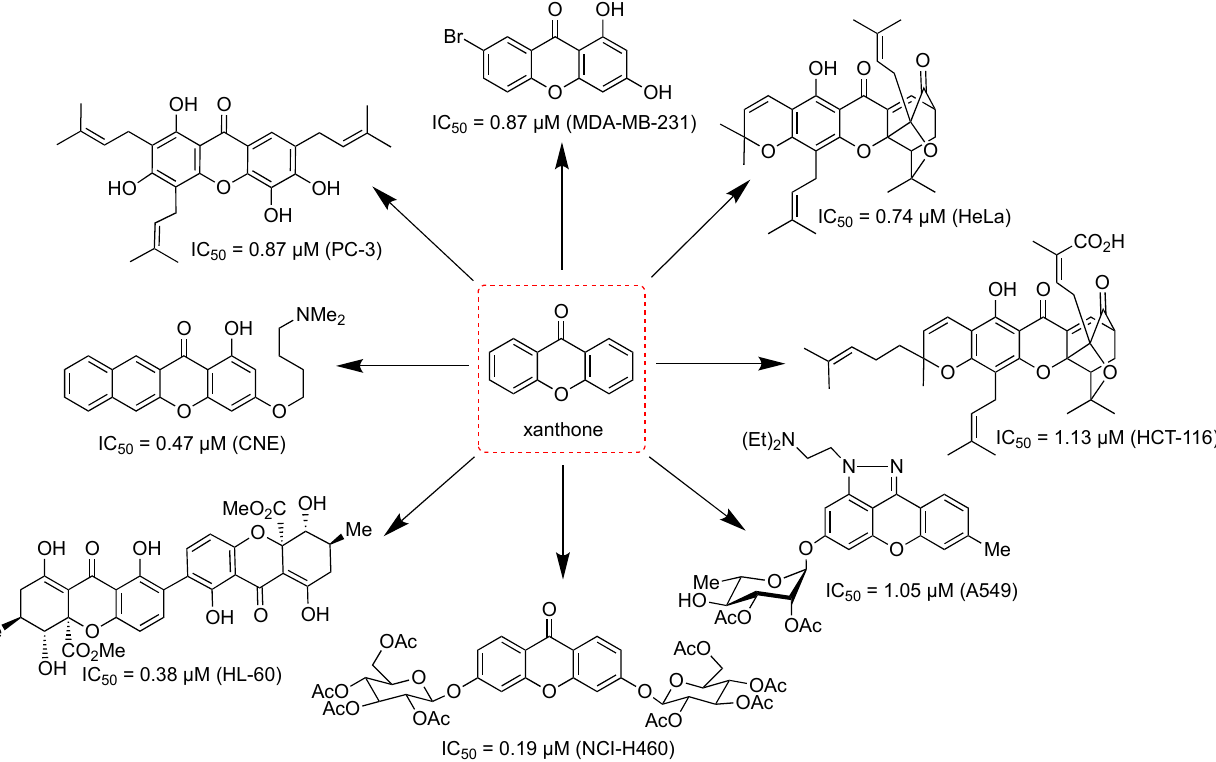
Figure 12. Summary of the most promising anticancer agents based on xanthone derivatives in this review.